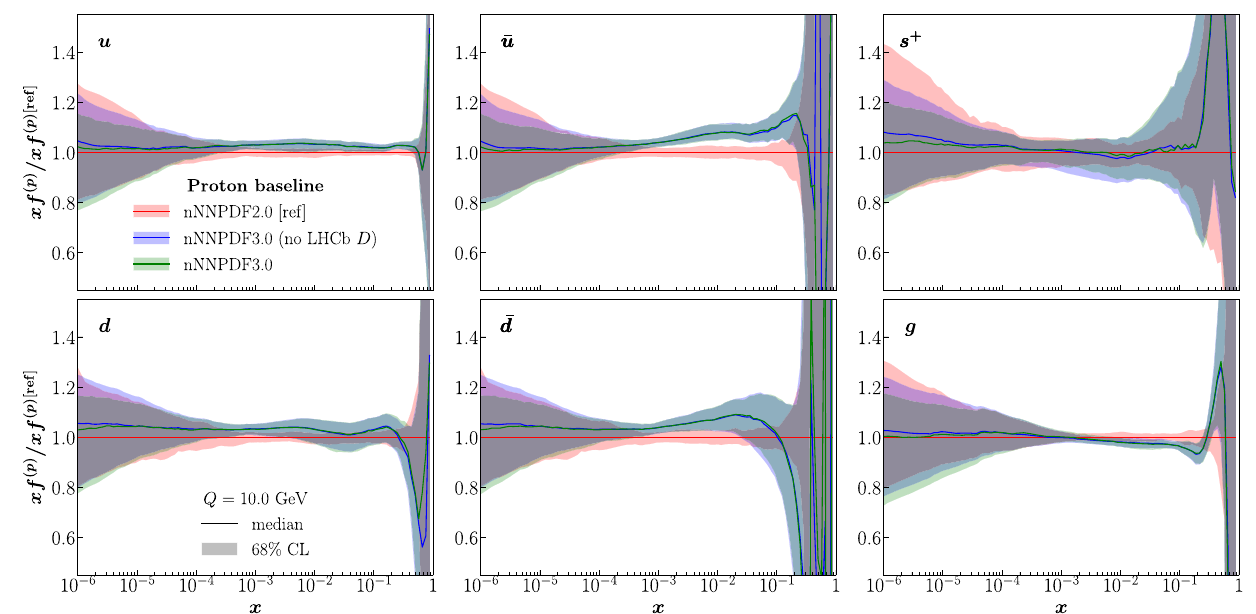
Fig. 2 Comparison between the free-proton baseline PDFs used in nNNPDF2.0 and in nNNPDF3.0, without and with the LHCb D -meson data. These PDFs are used to enforce the A = 1 boundary condition in the corresponding nPDF fits by means of Eq. (3.8). Results are nor-